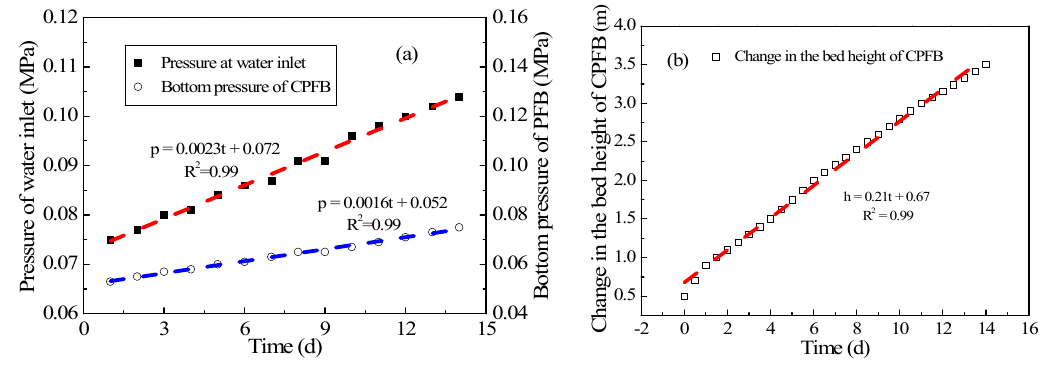
Figure 7. Change in ( a ) pressure and ( b ) bed height with operation time.